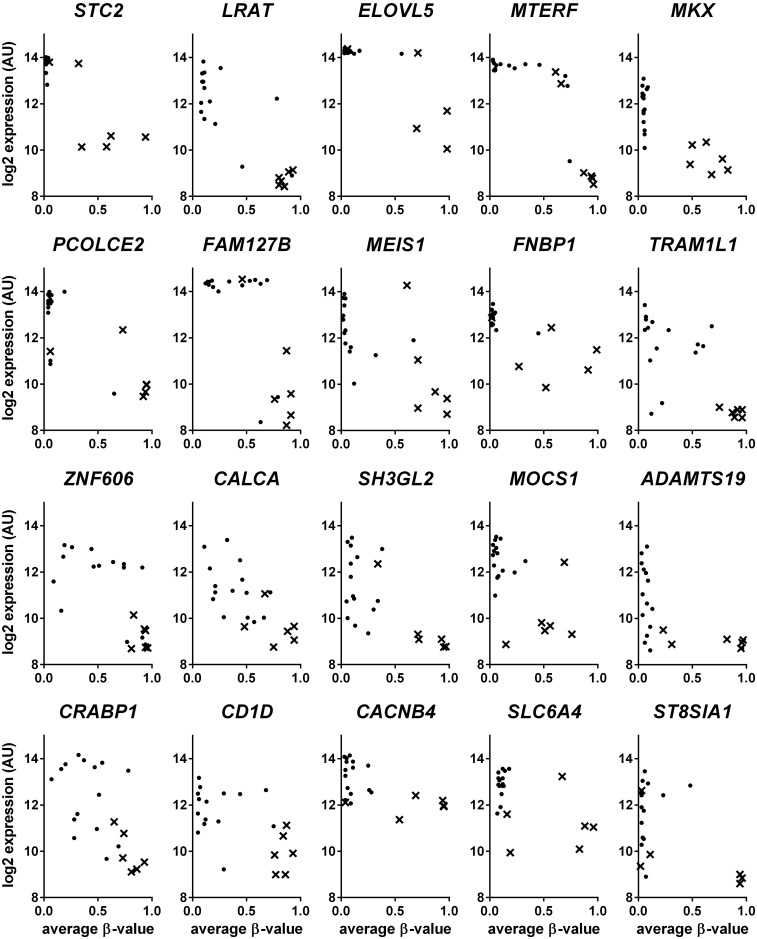
Genes showing a negative correlation between gene expression and DNA methylation.Average β-values are plotted on the x-axis, log2 gene expression values on the y-axis. Dots represent a cell line; BRAF mutant cell lines are marked with an x.